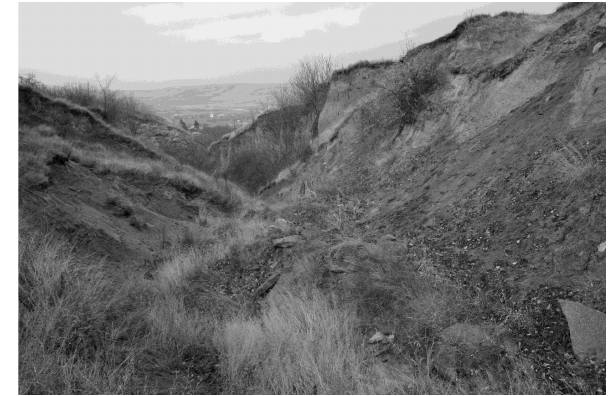
Fig. 23. The depositing of the fallen material in the secondary thalweg